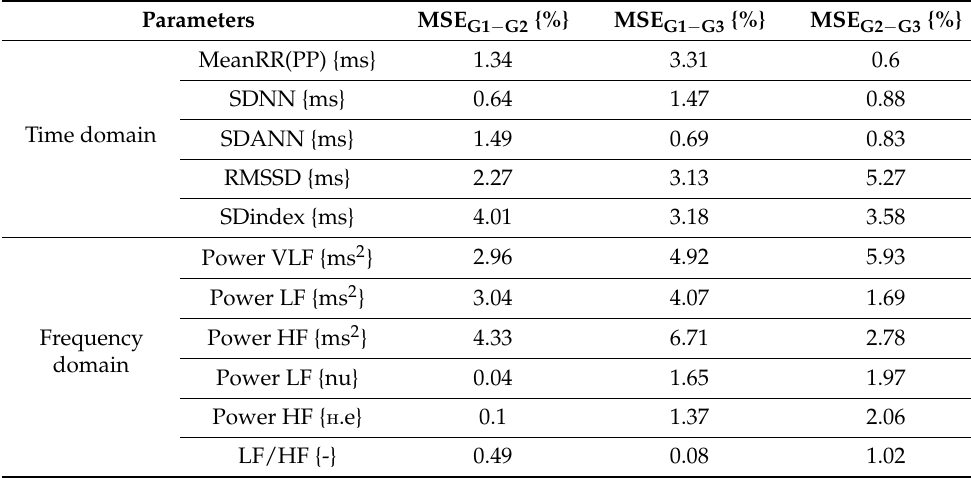
Table 8. The relative error between the ECG, Holter, and PPG records.